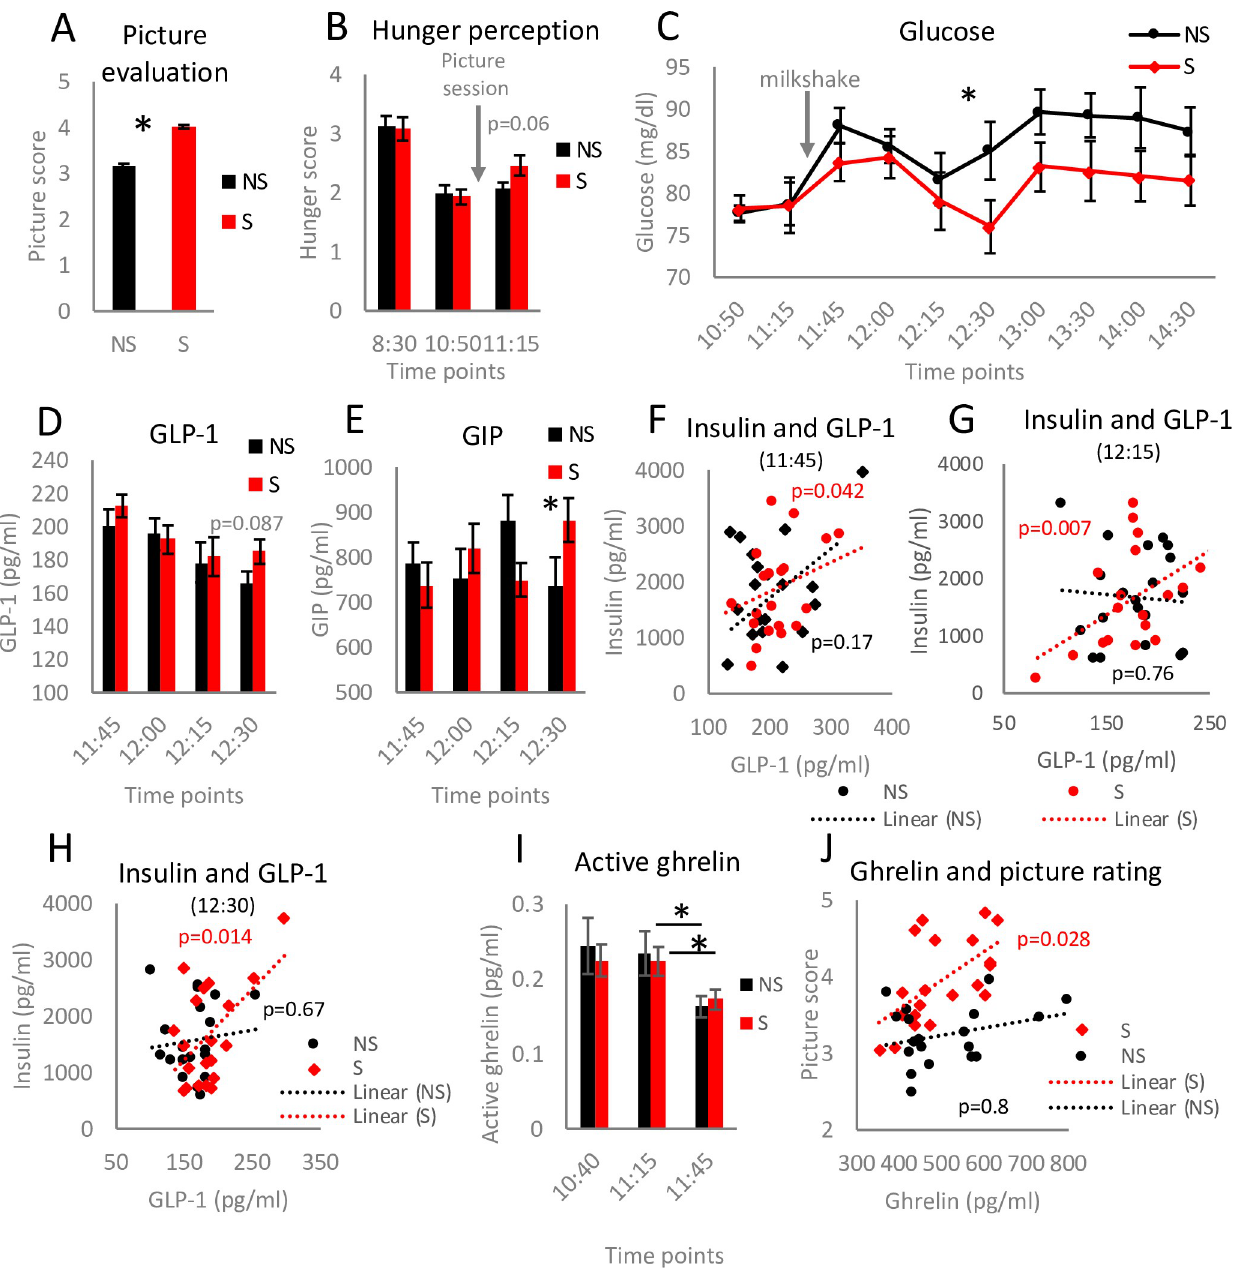
Fig 3. Exposure to food pictures influences postprandial blood glucose and appetite-related peptides. The participants ranked the pictures on a scale 1–5 (A). Hunger level on a scale 1–5 was rated by the participants at the indicated time points (B). Glucose levels were measured at the specified sampling time points (C). GIP (D) and GLP-1 (E) concentrations were quantified in blood samples collected at the indicated time points. Linear regression was used to validate the relationship between insulin and GLP-1 (F-H) for blood samples collected at the chosen time points. The concentration of active ghrelin in blood samples was assessed (I). Linear regression was applied to analyse interconnection between total ghrelin and picture score (J). Two-tailed Student’s t- tests were used to compare the experimental groups of panel A; n = 20, � p < 0.05. For panels B, D, E and I ANOVA with Bonferroni correction for multiple testing was applied. Error bars represent the mean ±